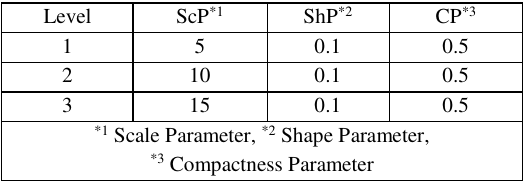
Table 2. Segmentation parameters for plot number = 3.